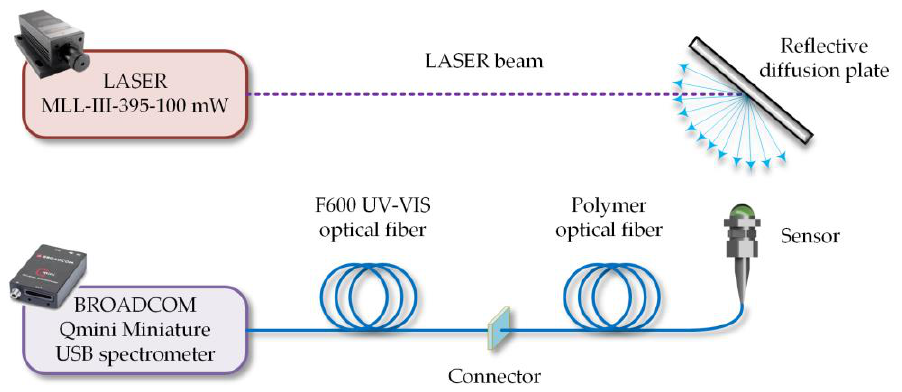
Figure 4. Experimental setup of the luminescent measurements of the fabricated sensor heads.